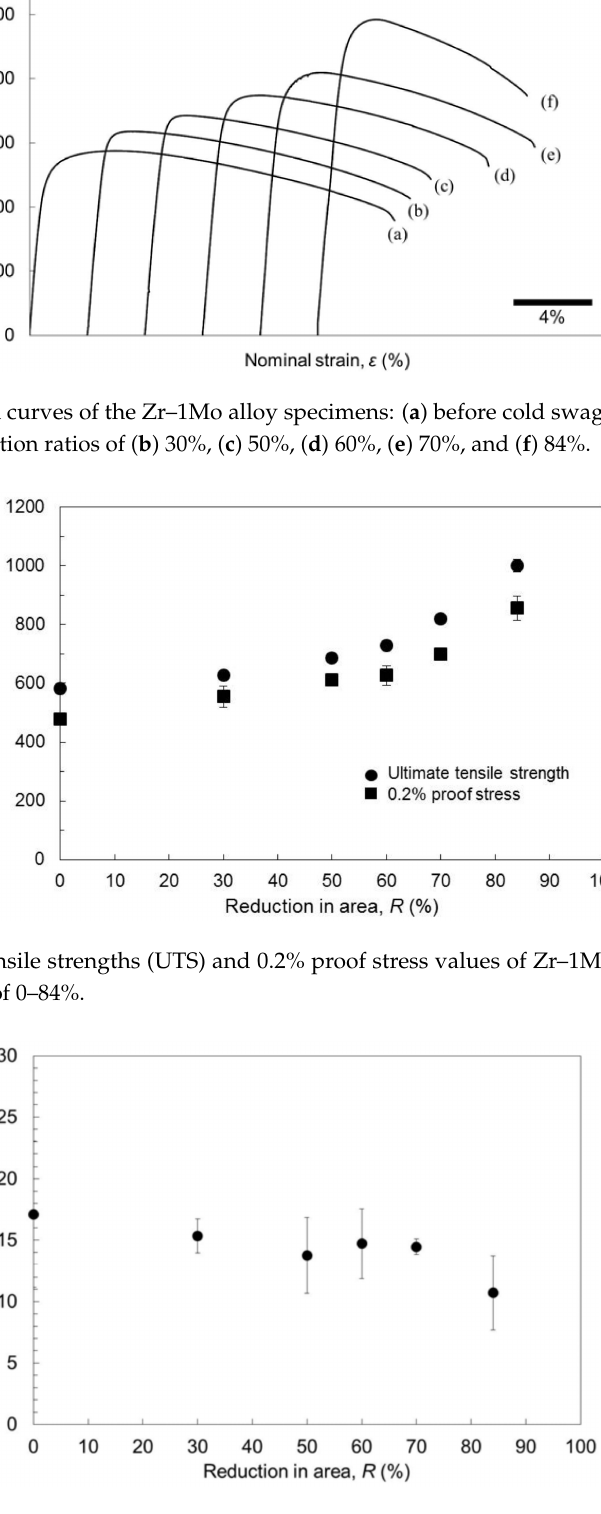
Figure 8. Elongation to fracture values of Zr–1Mo alloy specimens with area reductions of